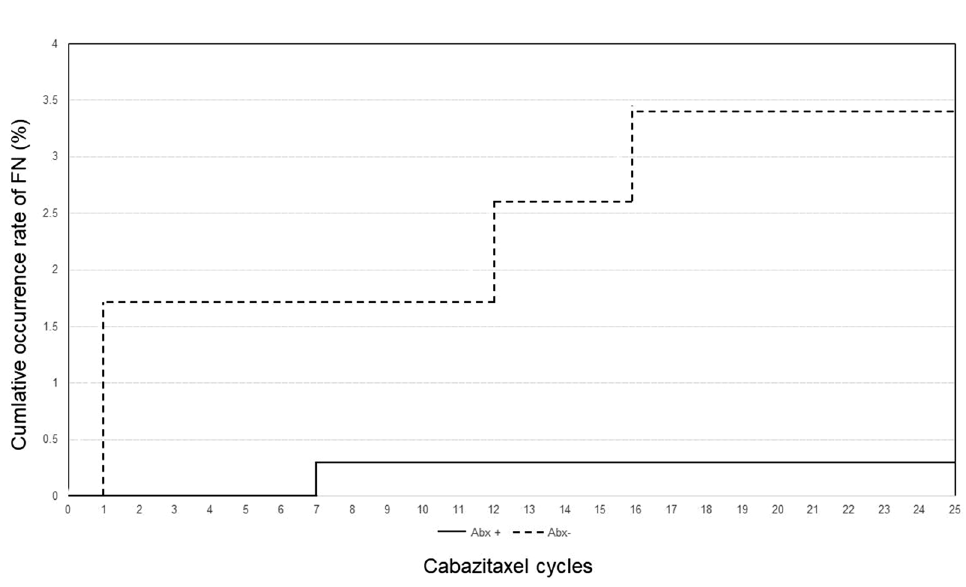
Figure 1. The number of cabazitaxel cycles and the cumulative occurrence rate of FN occurrence cycles between the group of cycles with prophylactic antibiotics and cycles without prophylactic